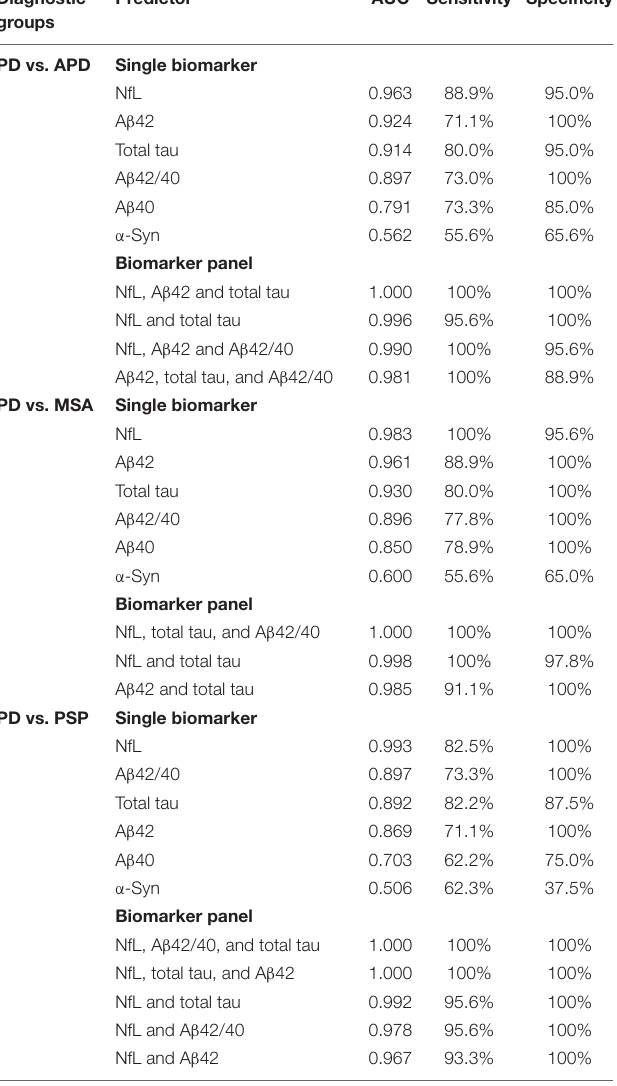
TABLE 4 | Discriminatory value of plasma NfL, total tau, A β 42, A β 40, A β 42/40 and α -syn as a single biomarker and as part of plasma biomarker panel in differentiating MSA from PSP.